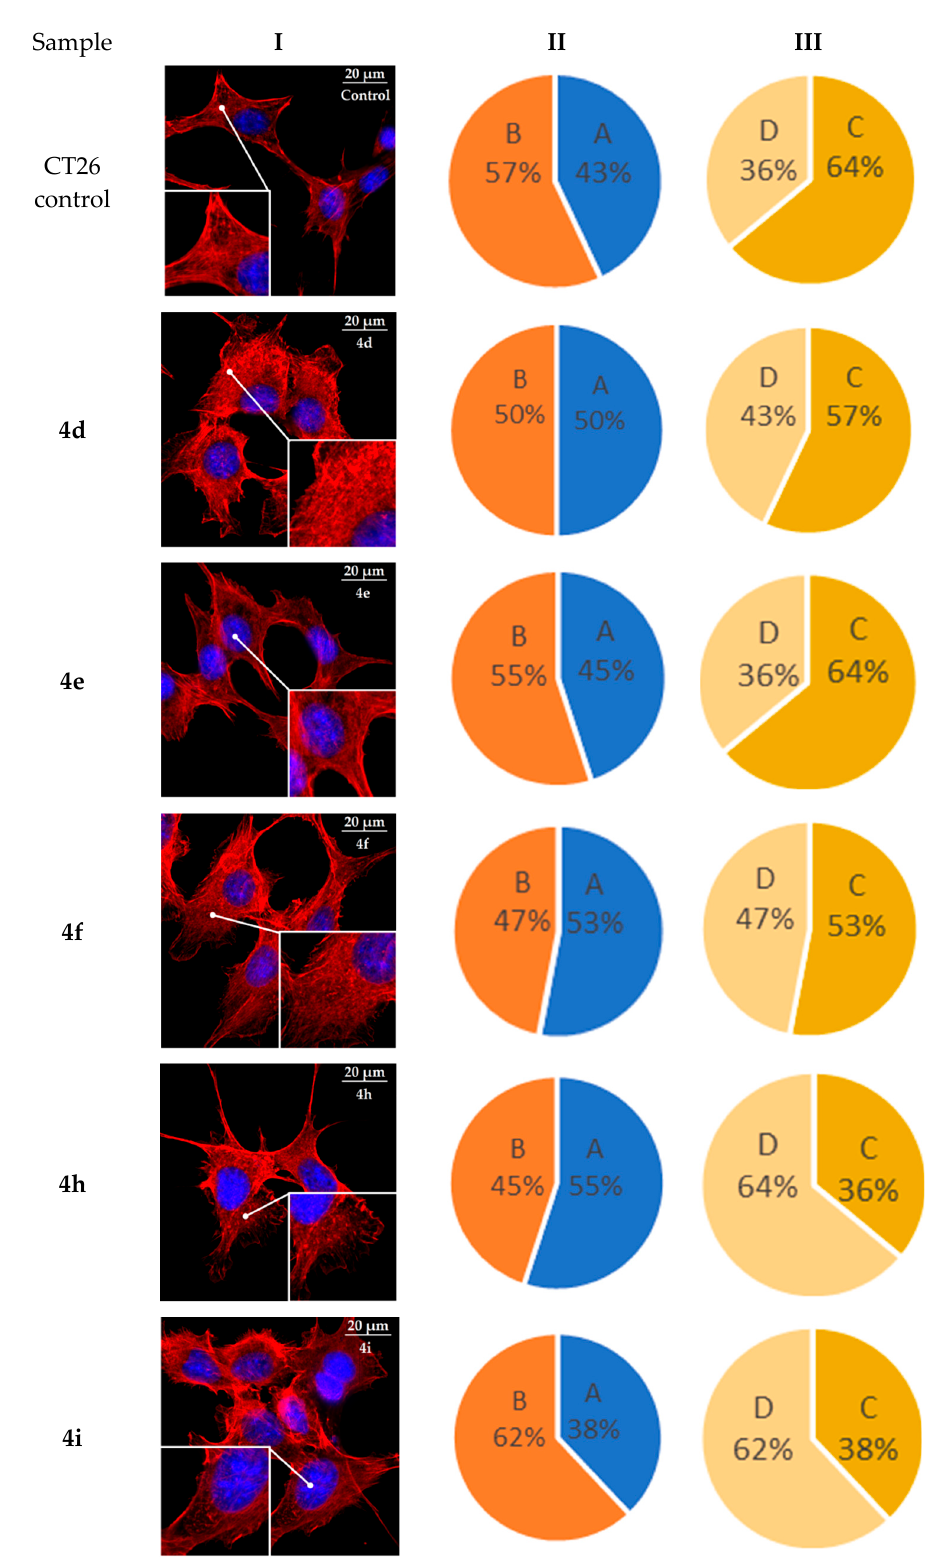
Figure 15. State of actin cytoskeleton of CT26 cells after treatment with 3-azaspiro[bicyclo[3.1.0]hexane-2,5 ′ -pyrimidines] 4d , 4e , 4f , 4h , and 4i . I: Images demonstrate the different stages of cell actin cytoskeleton. II: Pie charts demonstrate percentage of cells with filopodia-like deformations (A) and without filopodia-like deformations (B). III: Pie charts demonstrate percentage of cells with normal stress fibers (C) and disassembled stress fibers (D).